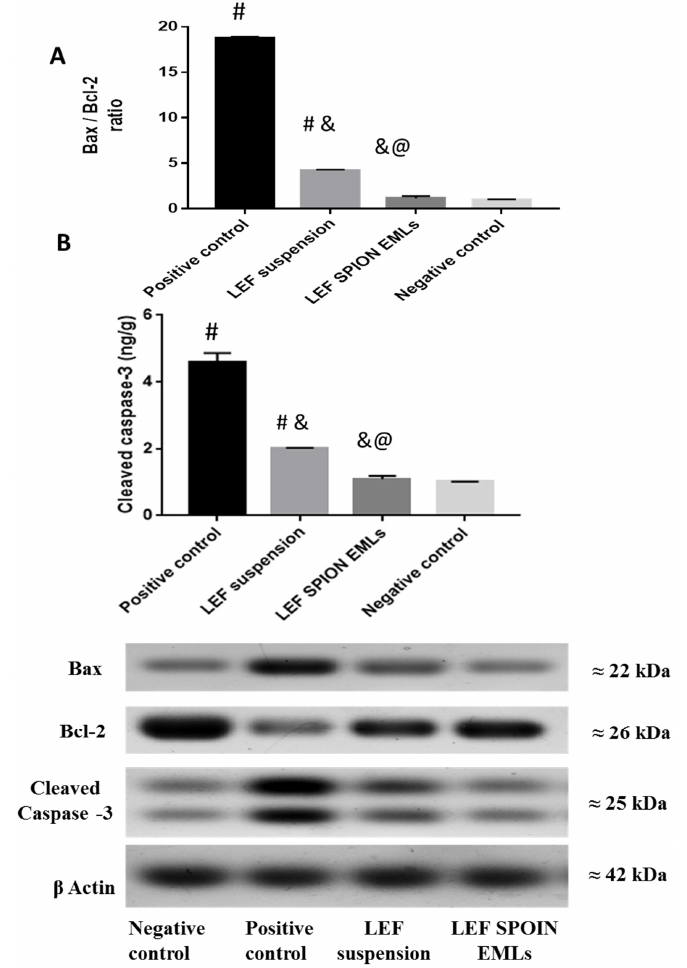
Figure 9. Effect of LEF suspension and LEF SPION EMLs on Bax and Bcl-2 ratio ( A ) and cleaved caspase-3 level ( B ) in joints of different experimental groups. Values are expressed as mean ± SD; n = 3. Statistical analyses were performed using one-way analysis of variance (ANOVA) followed by Tukey’s post hoc test. # significant as compared to negative control group. & significant as compared to positive control group. @ significant as compared to LEF suspension. Significant difference was conducted at p < 0.0001.